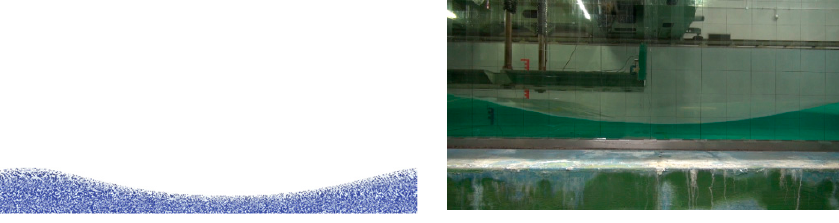
Figure 9. Comparison of wave elevation for A = 50.5 mm and T = 1.15 s with three water dept.